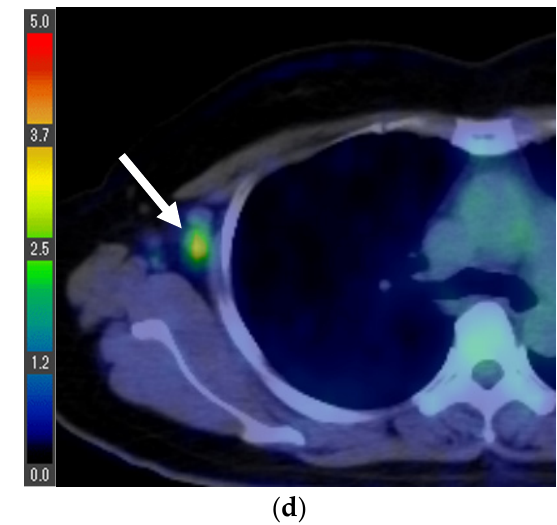
Figure 1. Maximum intensity projection (MIP) of 18 F-FLT PET ( a ), MIP of 18 F-FDG PET ( b ), axial image of 18 F-FLT PET/CT ( c ), and axial image of 18 F-FDG PET/CT ( d ). The axillary lymph node that showed the greatest accumulation differed between the 18 F-FLT PET/CT and 18 F-FDG PET/CT, with SUVmax values of 3.0 and 3.4, respectively (arrows). Patient 1 (Figure 1). Patient six experienced a first lumbar vertebra metastasis, and 18 F-FDG PET/CT